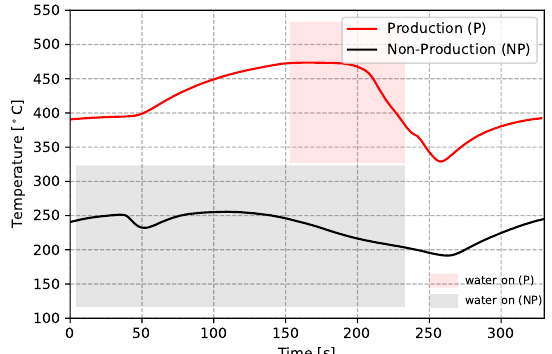
Figure 8. Temperature comparison of the two process conditions at TD17.